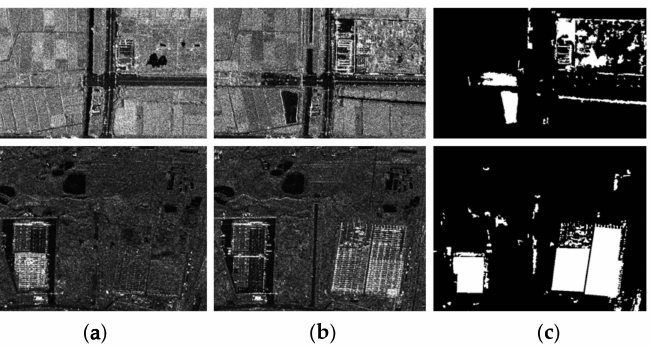
Figure 5. Images and corresponding reference images of SAR data set: ( a ) Images from T1; ( b ) Images from T2; ( c ) Ground